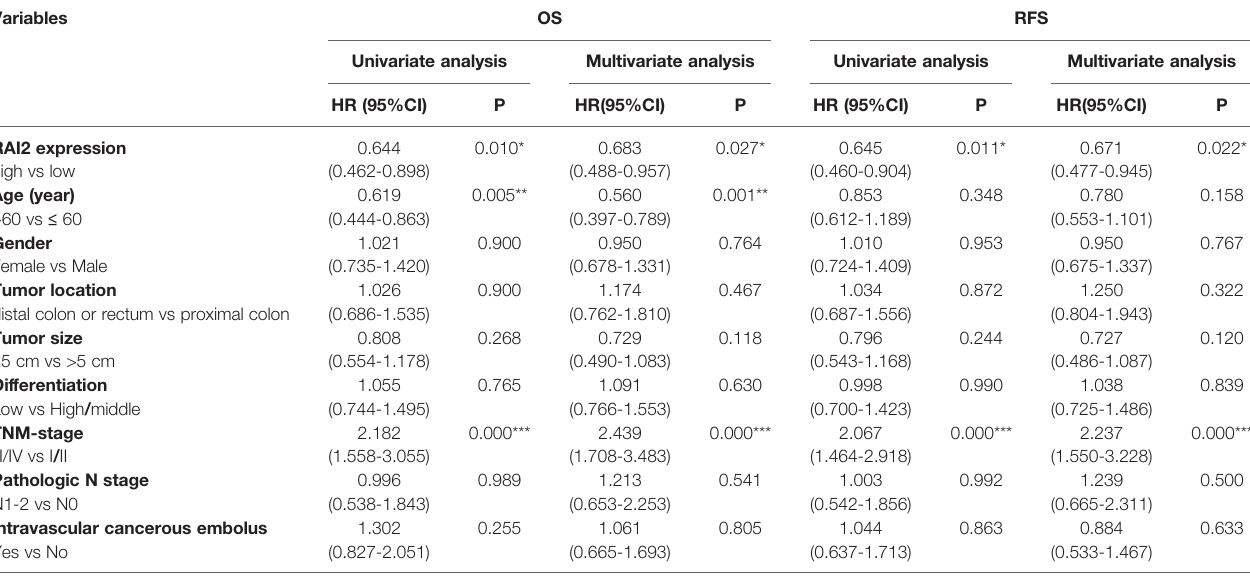
TABLE 2 | Analysis of RAI2 expression status with OS or RFS in colorectal cancer patients by Cox regression analysis.